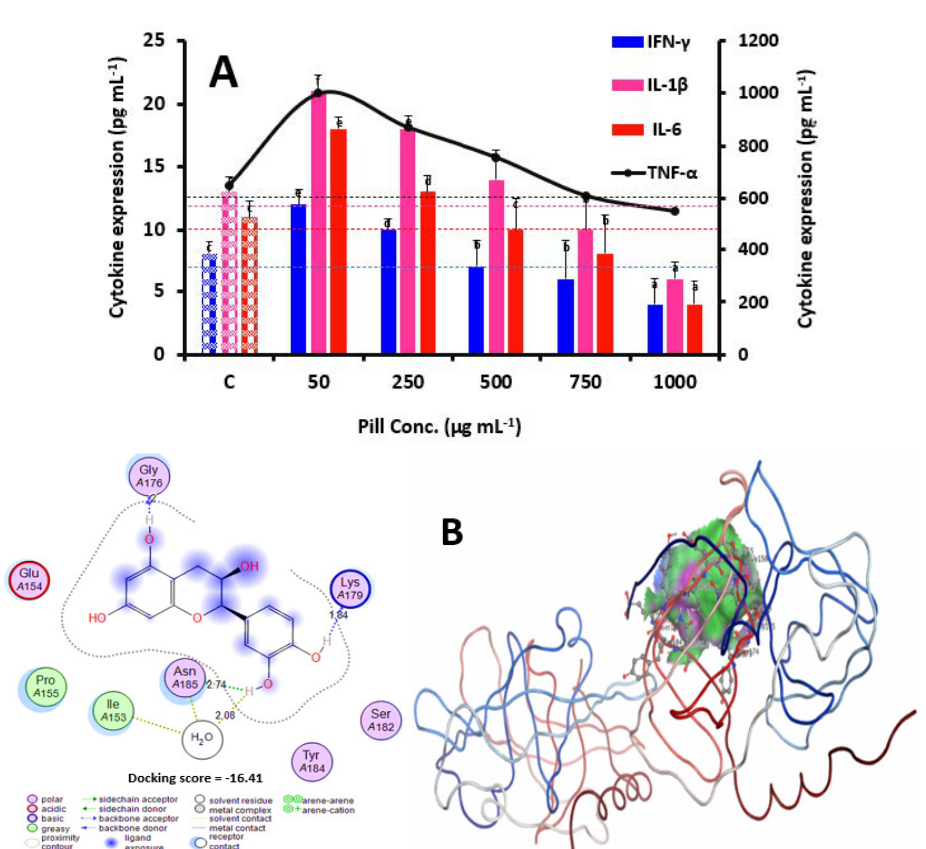
Figure 3. Effects of date seed pills on TNF- α , IL-1 β , IFN- γ , and IL-6 cytokine production in RAW264.7 cells ( A ). Lamin B1 worked as an inner loading control. NF- κ B, nuclear factor kappa-B; Nrf2,